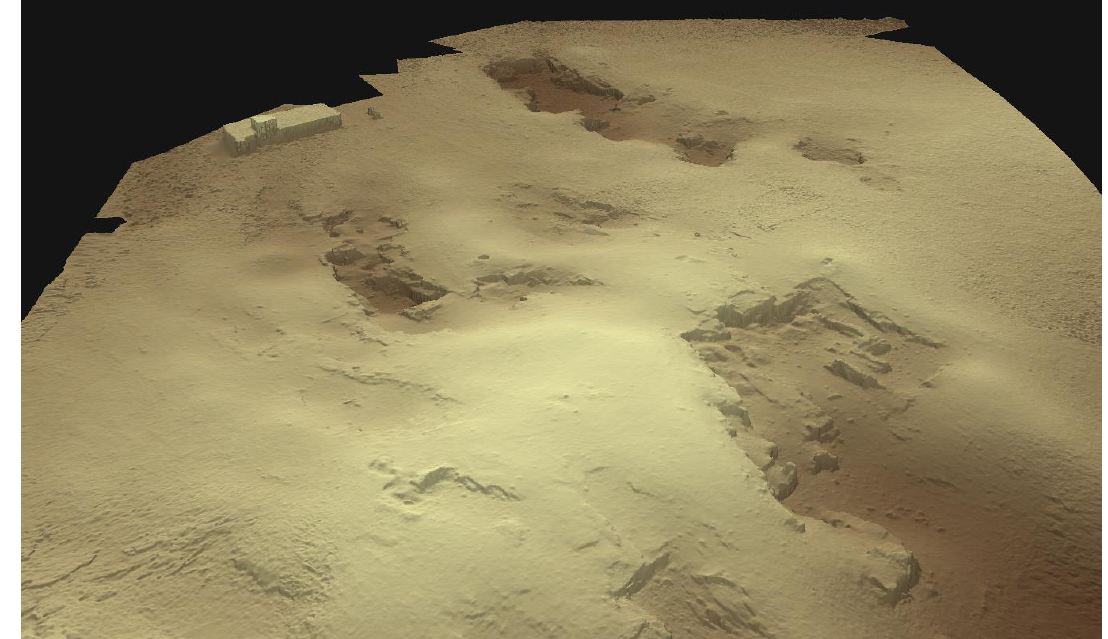
Figure 9. A rendering of the created DEM of a part of the